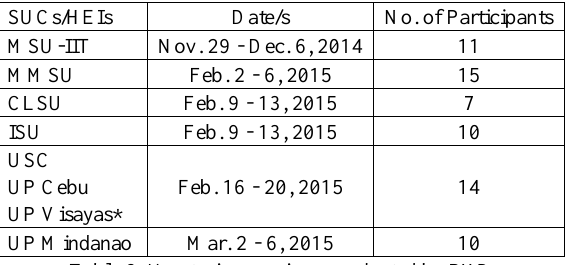
Table 3. Mentoring sessions conducted by PHD